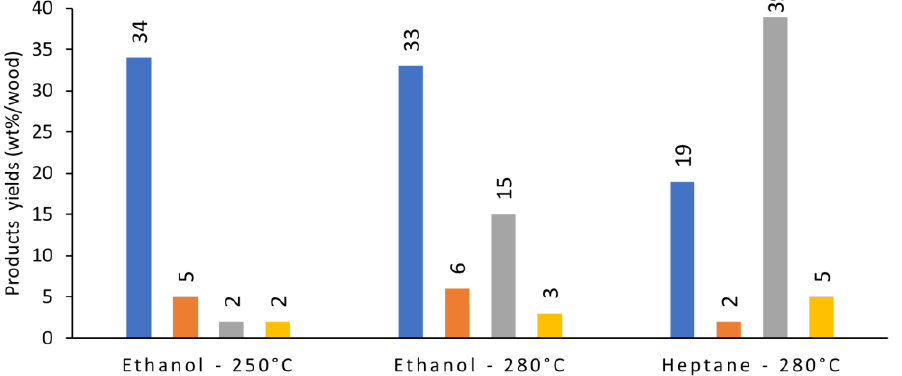
Figure 3. Products’ yields of pine wood fractionation: influence of the nature of the SC fluid and of the temperature. Conditions: Batch reactor. m pine wood = 2.5 g, m solvent = 27 g, 1 h in SC ethanol or SC n-heptane at 250 °C or 280 °C.